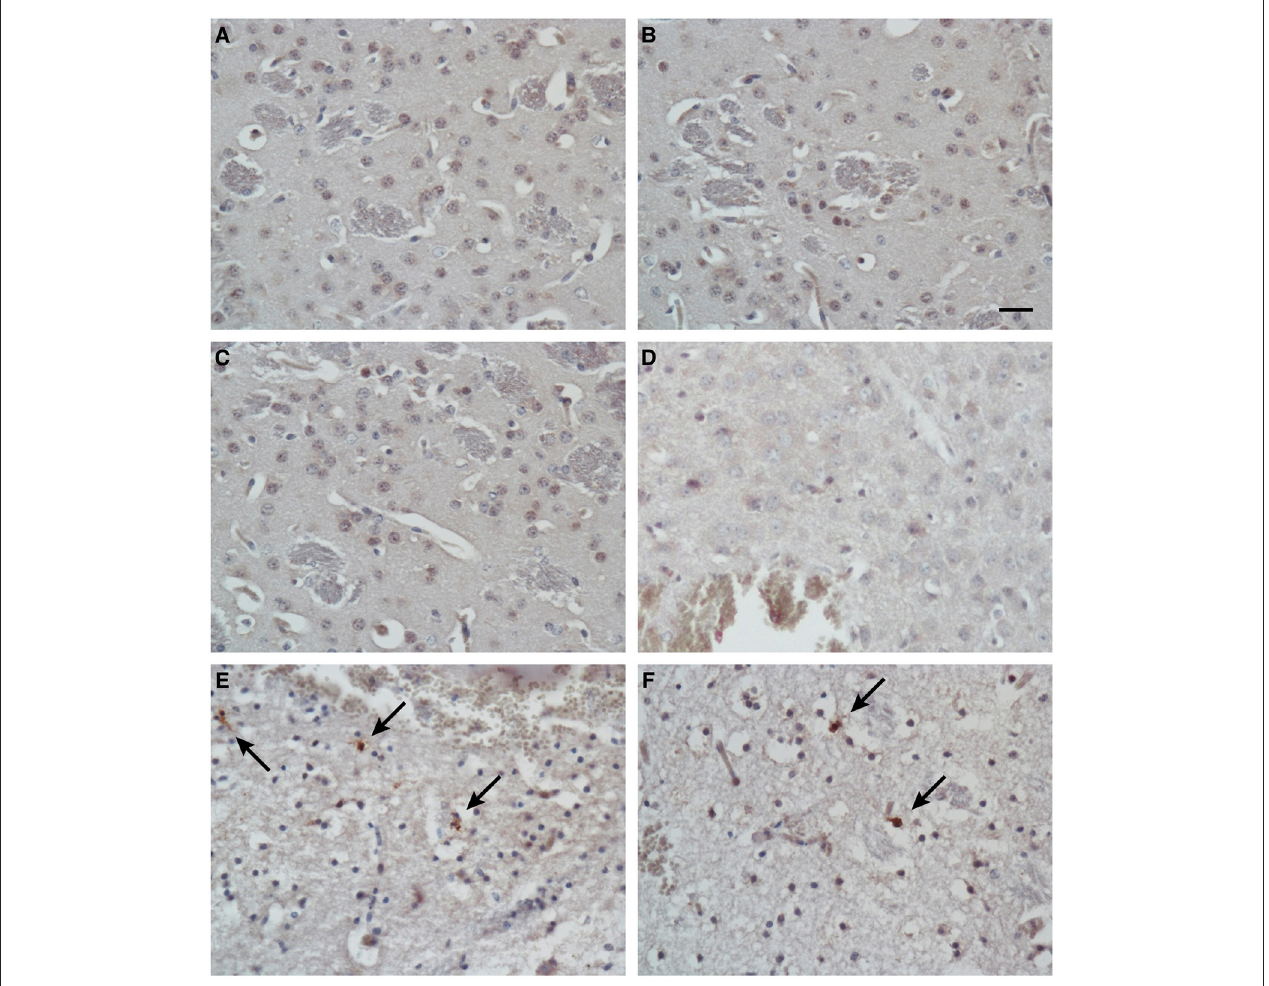
FIGURE 7 | Immunohistochemical analysis of apoptotic cells in tissues after injection. Immunostaining for cleaved caspase 3 in brain tissues from blank control mice (A,B) , control mice injected with non-specific peptide (C,D) , and mice injected with synthetic ZCP mimic peptide (E,F) . Apoptosis increased dramatically in the synthetic-peptide-treated mouse brains. Arrow indicates cells positive for cleaved caspase 3. Bars: 100 µ m. were observed by microscopy. Each experiment was